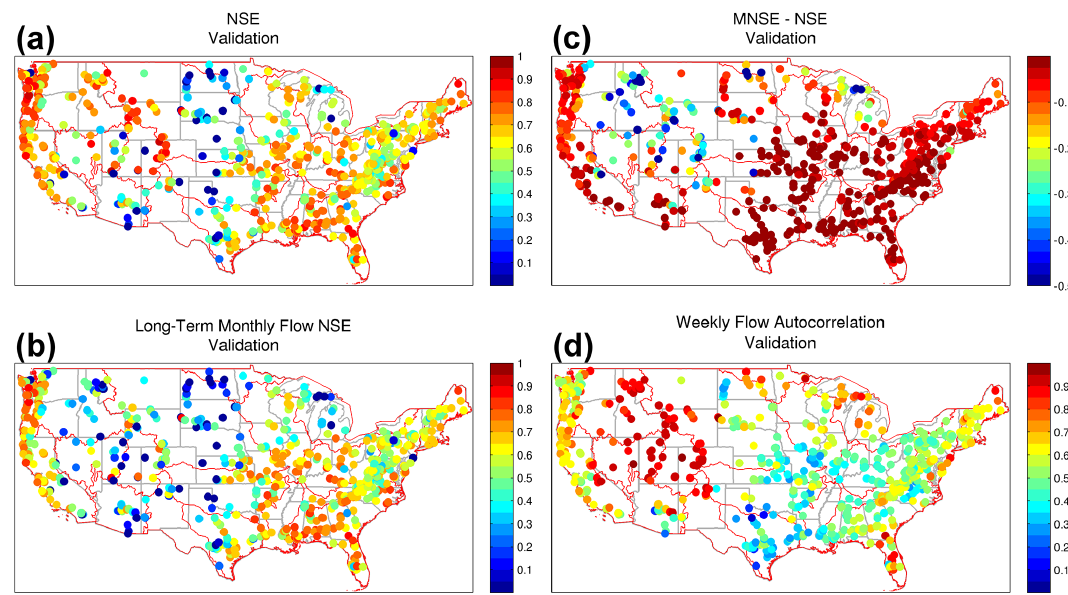
Figure 5. (a) Spatial distribution of NSE, (b) NSE using MNSEs rather than the long-term mean flow, (c) MNSE – NSE for the validation period, and (d) weekly flow